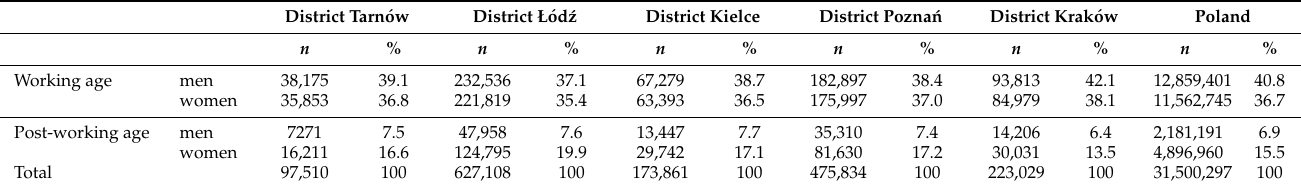
Table 1. Population structure in terms of the number of adult women and men of working age and post-working age in the poviats of the cities of Tarn ó w, Ł ó d´z, Kielce, Pozna´n, in the Krak ó w district and in Poland in total in 2013. District Tarn ó w District Ł ó d´z District Kielce District Pozna´n District Krak ó w